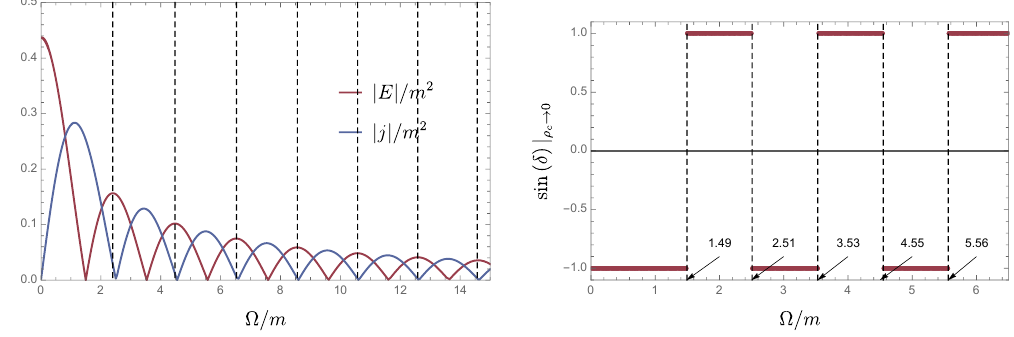
Figure 9 . On the left we plot j E j =m 2 and j=m 2 versus the driving frequency for critical embeddings. On the right we depict the value of sin (cid:14) for embeddings with (cid:26) c = 0. In (cid:12)gure 9 we plot together the j E j =m 2 and j=m 2 curves as a function of (cid:10) =m . We notice that the current curve also displays a lobe-shaped structure, displaced with respect to the j E j =m 2 curve, whose maxima (zeros) are very close to the zeros (maxima) of the j E j =m 2 curve. We have also checked that sin (cid:14) ( (cid:26) ! 0) = (cid:6) 1 and changes discontinuously its sign c at the discrete set of frequencies described above (see (cid:12)gure